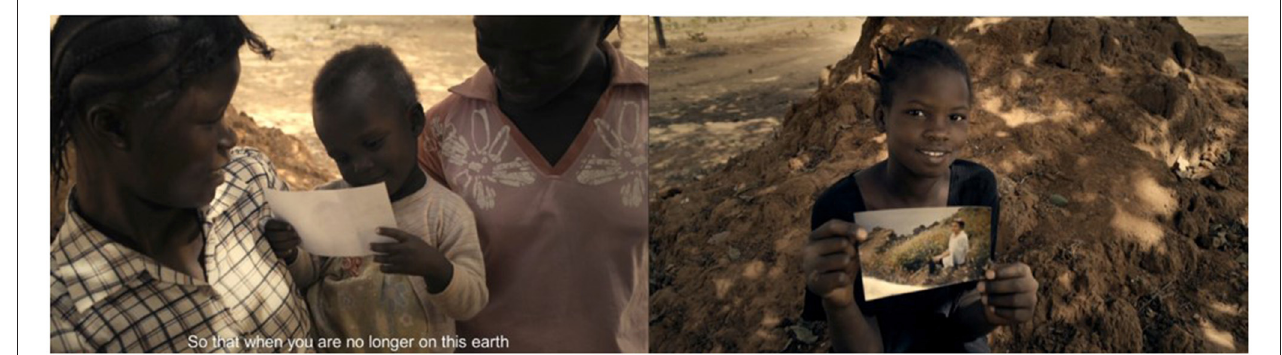
FIGURE 2 | Unicef Spot B—two key frames of the spot based on thankfulness and reciprocity. Source: Ambrogetti (2019, p. 192). Page 191 contains the main sentences of the spot with a brief description of the storytelling. On page 192 there are the graphs of the neurocognitive performance of the spot with the relative